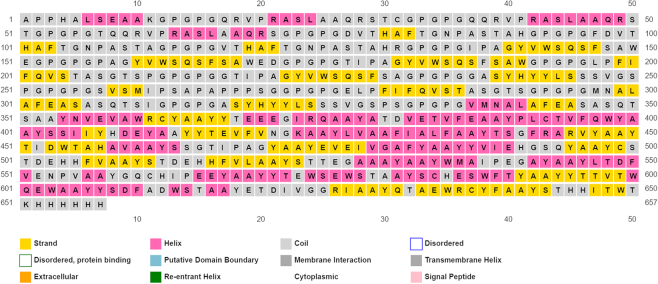
The secondary structure features of the final subunit vaccine sequence. The predicted protein consists of α-helices (14.0%), β-strands (22.0%) and coils (63.0%), while 17% of its positions were predicted as disordered.